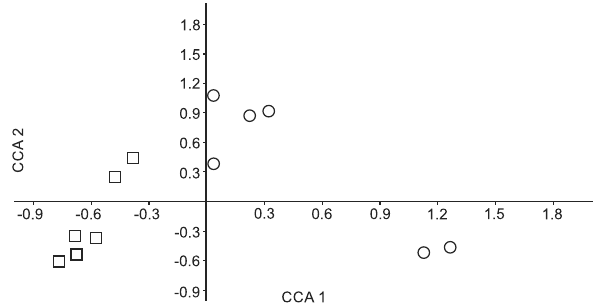
Figure 2. Scores for sampling points on the first two axes of the Canonical Correlation Analysis (CCA) in the drought/flood period: ( (cid:133) ) flood period and ( (cid:123) ) drought period.